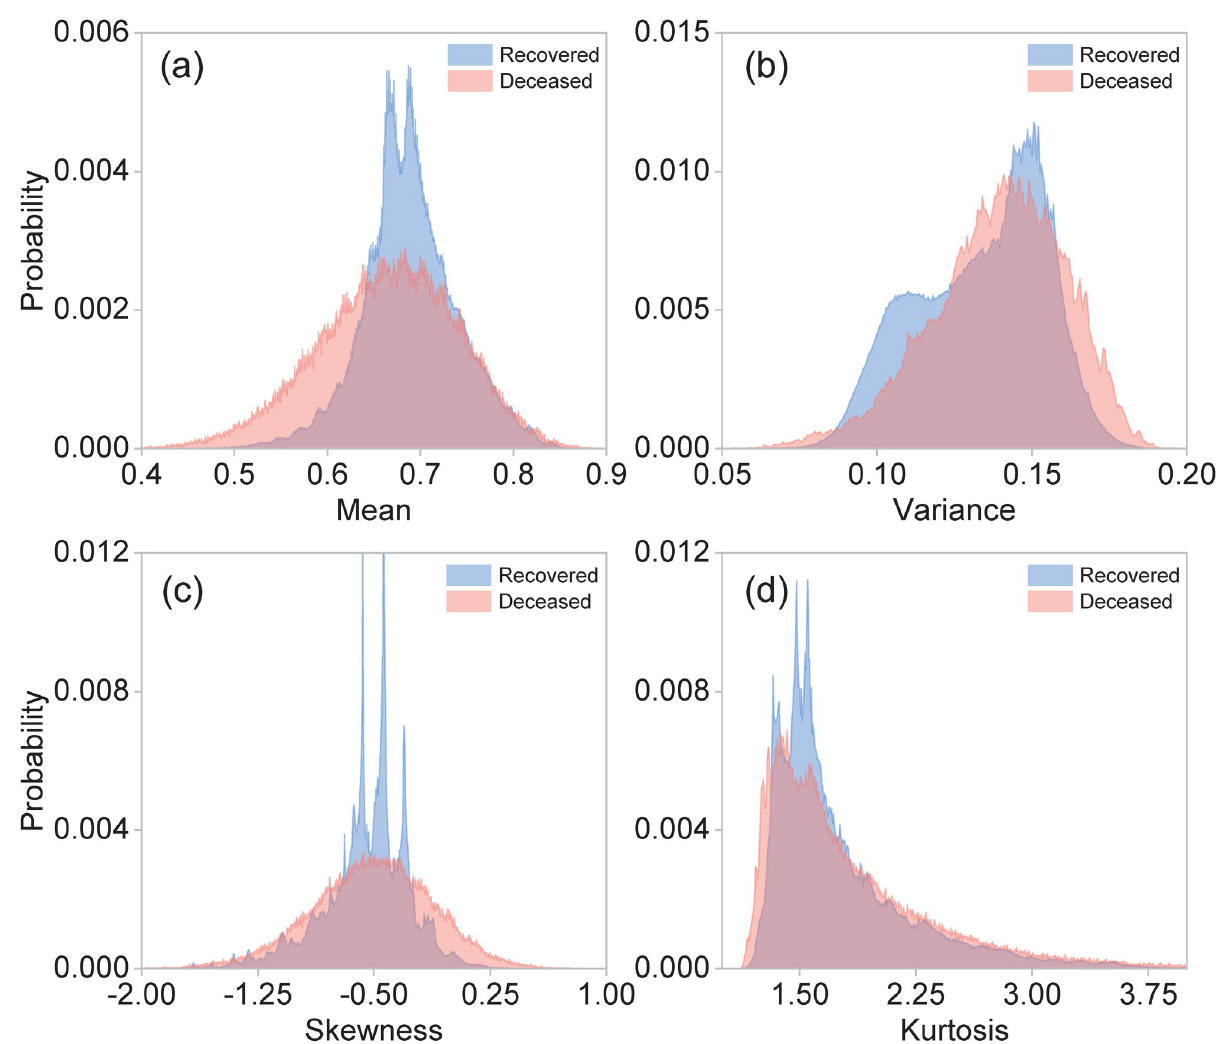
Fig 1. Normalized distributions for different central moments: (a) mean, (b) variance, (c) skewness, and (d) kurtosis, for class 1 (recovered patients), shown in blue and for class 2 (deceased patients), shown in red. These central moments were computed from the 21 elements of the characteristics vector for each patient. These distributions were plotted using the entire dataset with 4, 700, 464 observations.